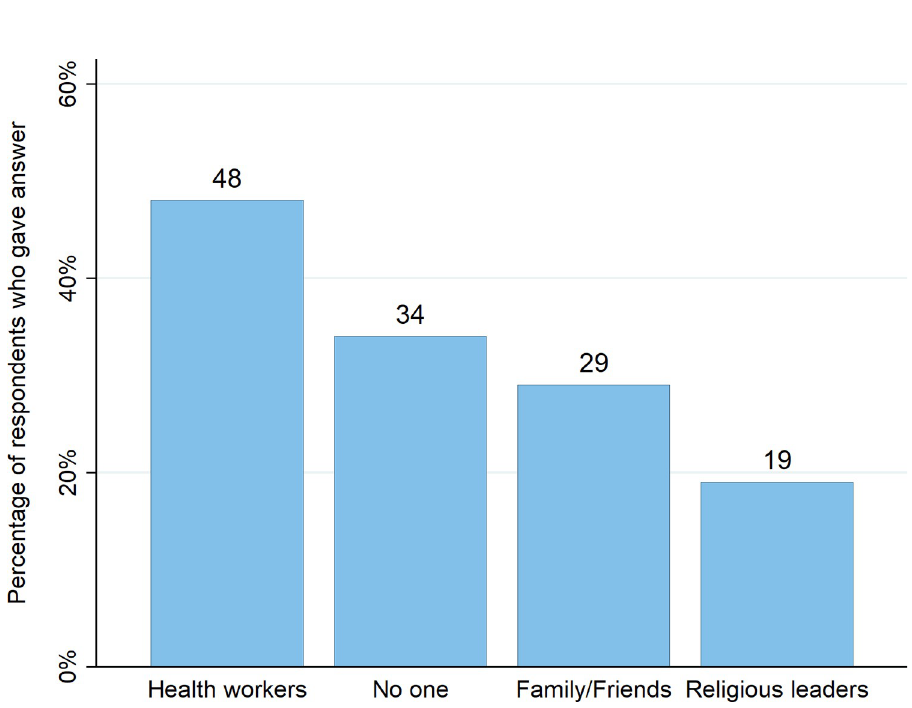
Fig 4. Top three groups in people who could change respondents’ minds about vaccination. Note: people could provide more than one response. As a result, responses total to more than 100%.